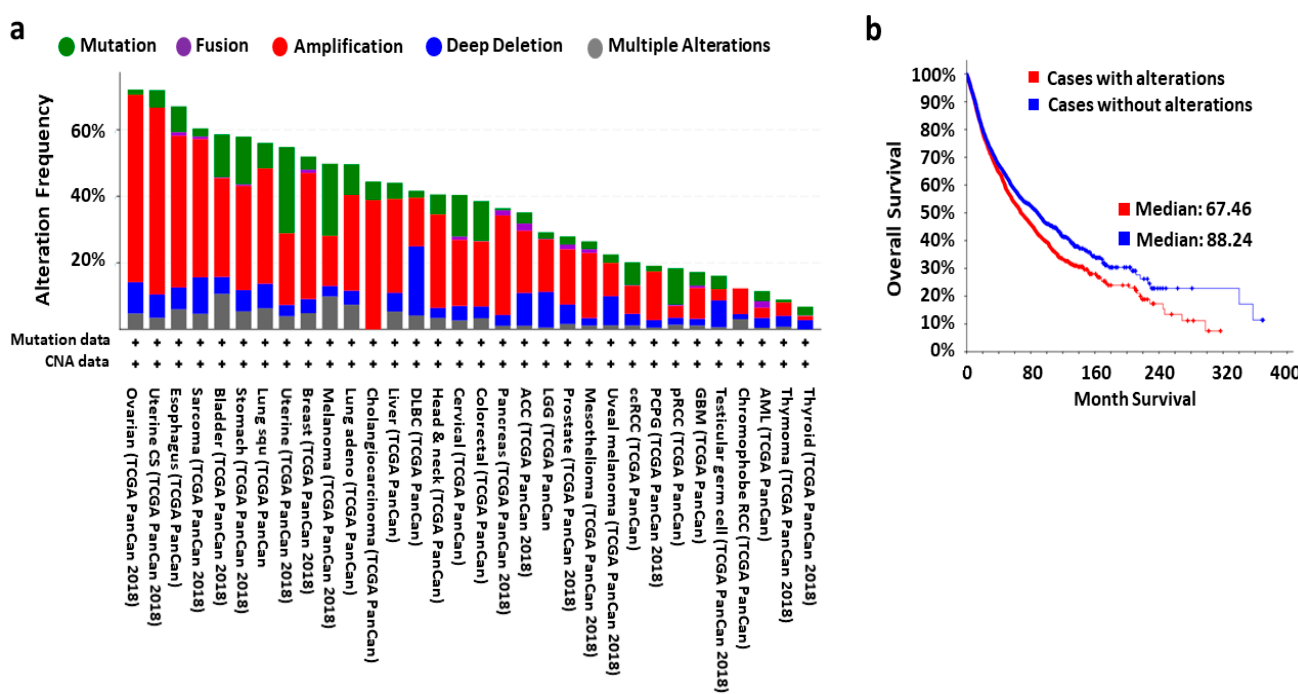
Figure 1. Alteration status of ribosomal proteins (RPs) in cancers and its correlation with patient’s survival status. ( a ) Bar diagram showing the copy number alteration status of RPs in different types of cancers, the data obtained by analyzing 10,967 samples from “TCGA PanCancer Atlas Studies (32 categories)”, it showed that all of the 32 cancer types have altered the expression of RPs, while ovarian cancer, uterine cancer and esophagus are the top three types of cancer, of which more than 60% samples have alteration of RPs. ( b ) Survival graph showing that altered expression of RPs are negatively correlated with the survival status of cancer patients. All data were generated using the cBioPortal for Cancer Genomics (http://www.cbioportal.org/index.do) database from the cancer genome atlas (TCGA) Research Network (https://www.cancer.gov/about-nci/organization/ccg/research/structural-genomics/tcga).